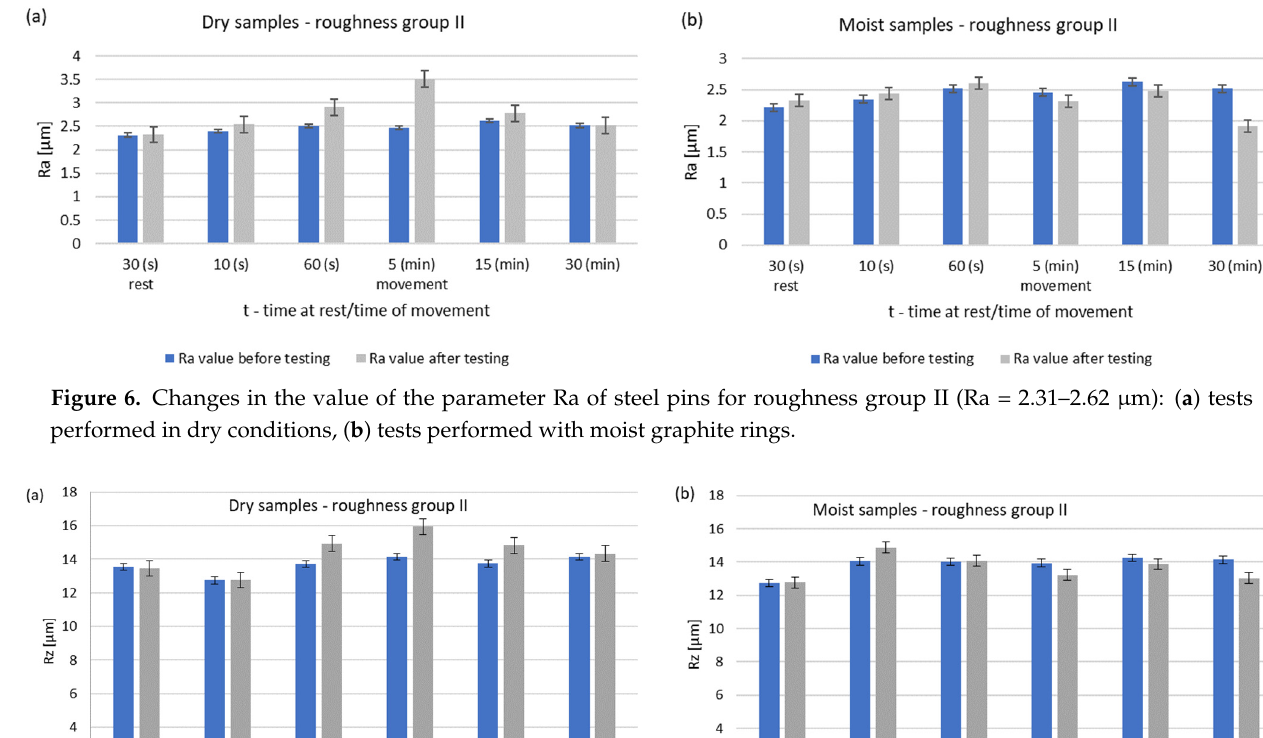
Figure 9. Comparison of Rz values of dry and wet ring samples for group II roughness. The greatest differences are seen after 5 min of friction node operation. The longer running time resulted in a decrease in the surface roughness of the pin. After 30 min of operation, the friction node with moist rings had a lower roughness than before the test. A decrease in roughness was also noted for the friction node running dry. The performed pin surface roughness measurements for group III are shown in Figures 10 and 11. Figure 10. Changes in the value of the parameter Ra of steel pins for roughness group III (Ra = 3.21–3.62 μ m): ( a ) tests performed in dry conditions, ( b ) tests performed with moist graphite rings.